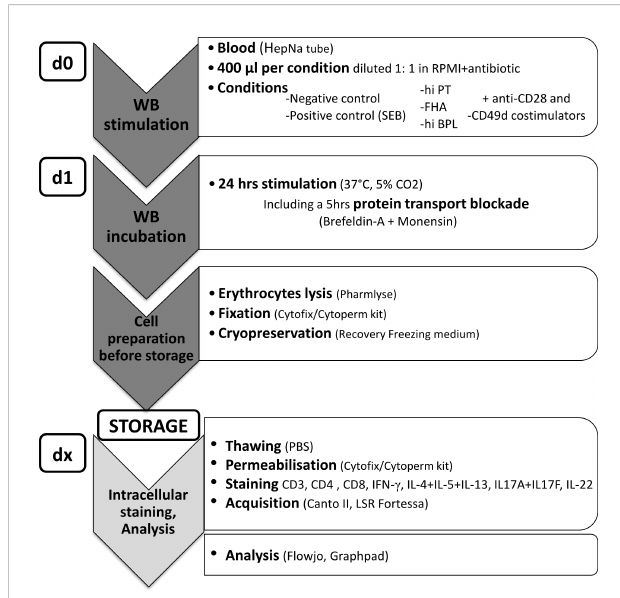
FIGURE 5 Work fl ow for the BpWB-ICS assay. Blood was collected in sodium heparin tubes and processed within three hours, maximum. Per stimulation, 400 µl of blood was diluted 1:1 with RPMI supplemented with gentamycin before incubation for 24 hrs in the presence of 1 µg/ ml anti-CD28 and anti-CD49 co-stimulants in 15 ml round-bottom polypropylene tube (day 0, d0). Diluted blood was stimulated with 5 µg/ml heat-inactivated (hi) PT, 5 µg/ml FHA or 10 µg/ml hi Bp lysate. Negative (no antigen) and positive (SEB) controls were used in parallel. Protein transport arrest reagents (10 µg/ml Brefeldin-A and 1/1,000 Monensin) were added during the last 5 hrs of the incubation. After 24 hrs incubation (d1), red blood cells were lysed with the Pharmlyse buffer (BD Biosciences), and the white blood cells were fi xed with the Fixation/Permeabilisation solution (BD biosciences), before freezing in the Recovery Freezing medium (ThermoFisher) and storage at -80°C for delayed analysis in batches (dx). After thawing in PBS, the cells were permeabilized with the BD Perm/Wash buffer (BD Biosciences), and stained with antibody panel 2 (Table 1) for analysis of IFN- g -, IL-4/ IL-5/IL-13-, IL-17A/IL-17F- or IL-22-producing CD4 + T cells to reveal Th1, Th2, and Th17-type responses,